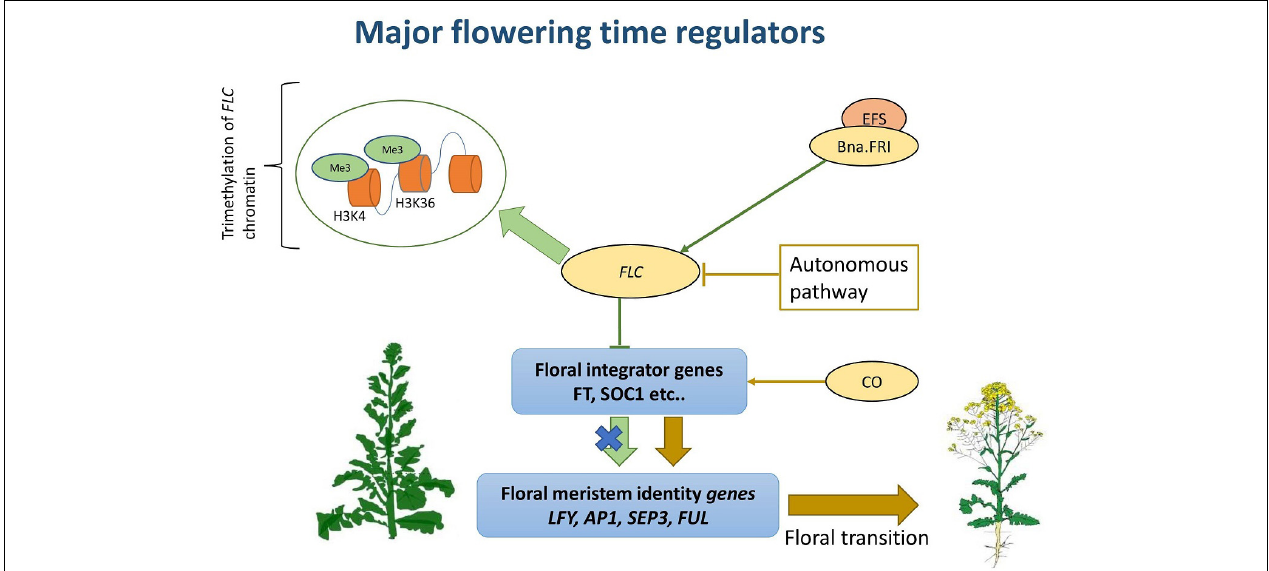
FIGURE 3 | Regulatory and signaling events involved in plant heat stress response.